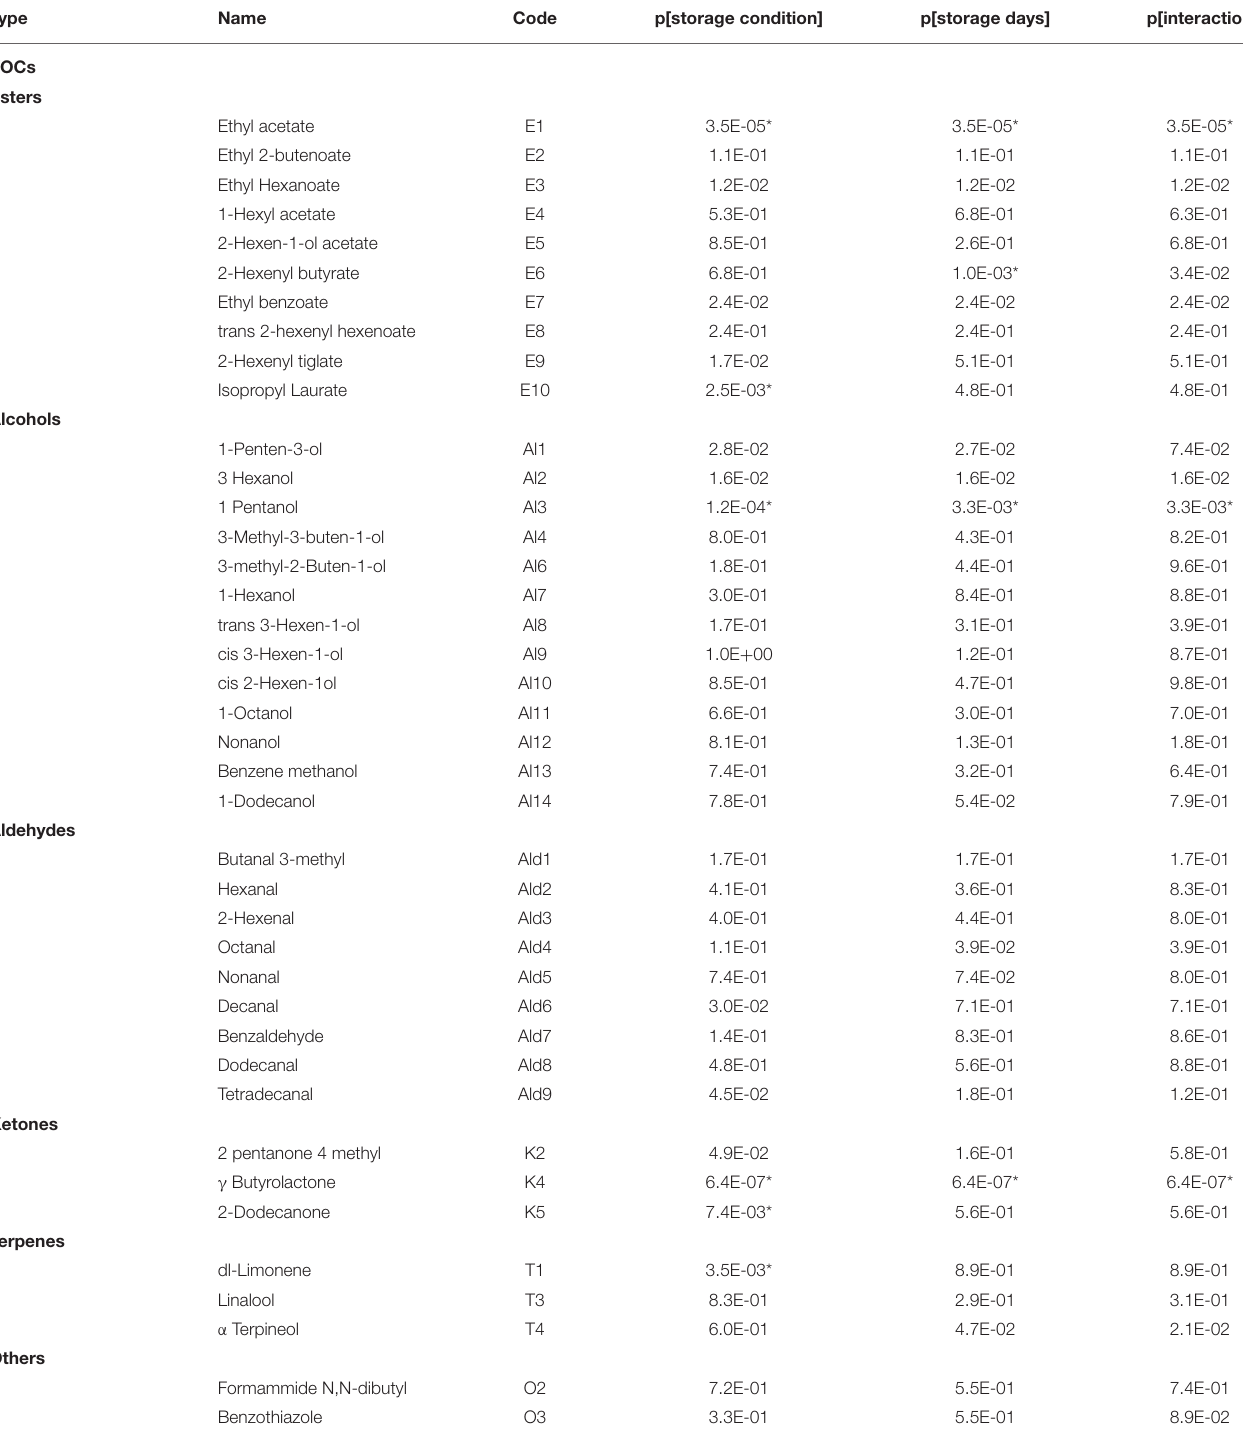
TABLE 2 | ANOVA: p -value ( p ) of the effects of storage condition (High-CO 2 and Air), storage days (14 and 21 days at 5 ◦ C), and their interaction on VOCs and E-nose data. Effects selected by Benjamini-Hochberg procedure assuming δ = 0.05 are indicated with